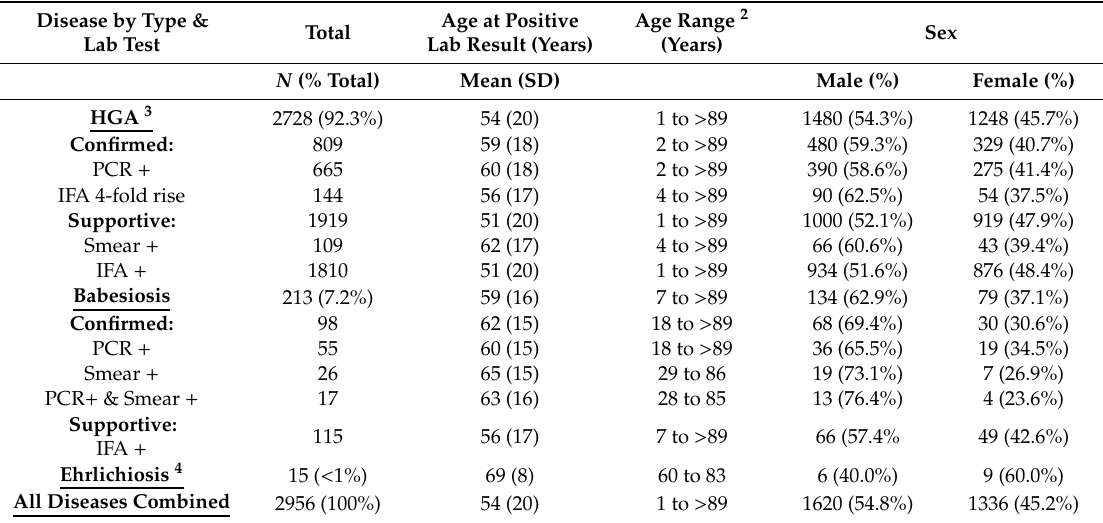
Table 1. Characteristics of non-Lyme tick-borne disease cases and laboratory confirmation 1 counts among the Marshfield Clinic Health Care System (MCHS) population: